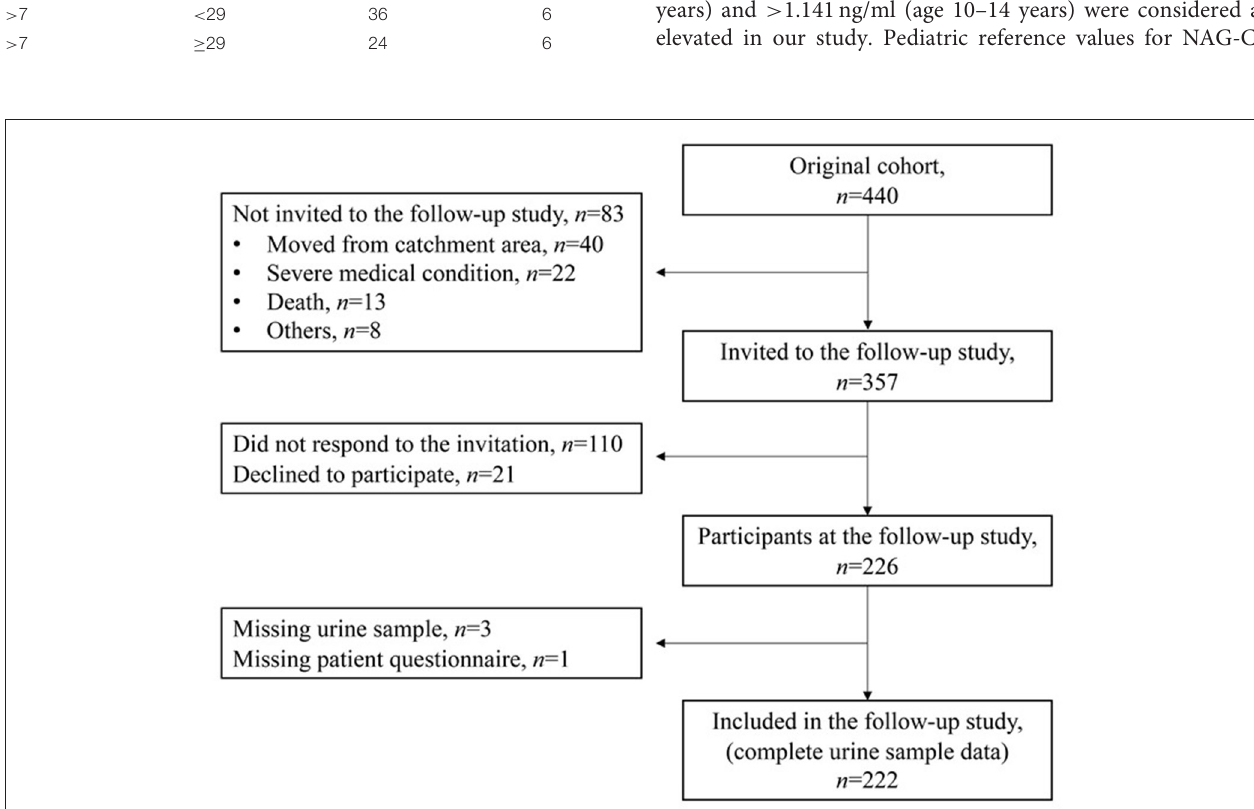
FIGURE 1 | Flow chart of the participants in the study from the original cohort to the present follow-up study.